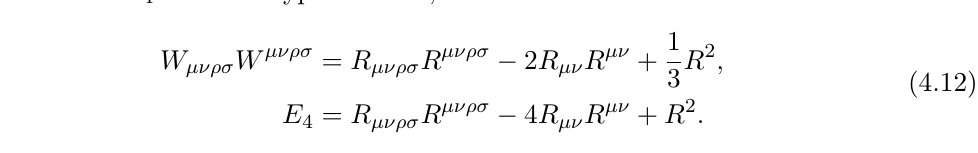
Table 4 . Coefficients of trace anomalies ( c, a ) data for the matter coupled N ≥ 1 , d = 4 EMSGTs. W W µνρσ and E have the typical µνρσ 4